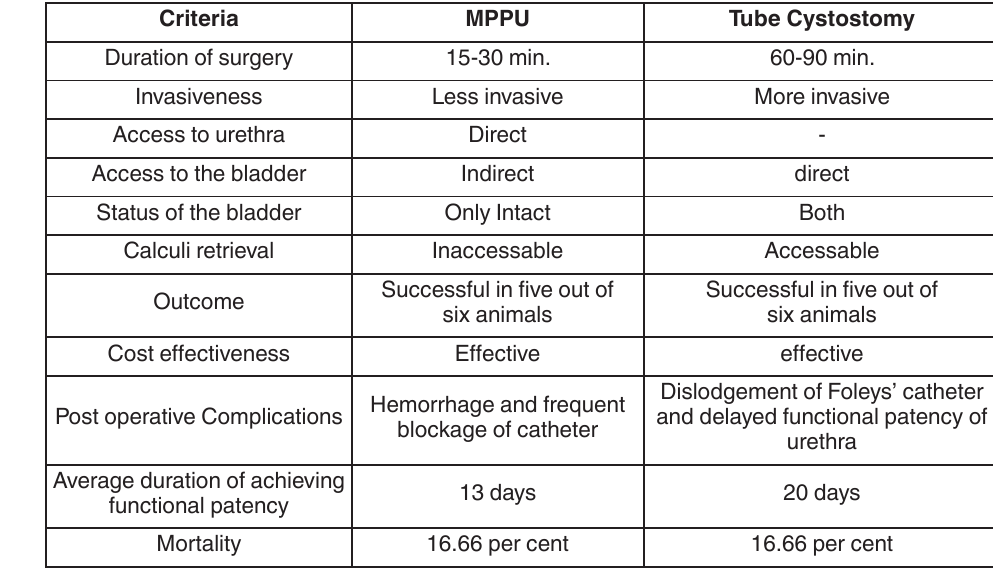
table 1: comparison of the surgical techniques of MPPU and tube cystostomy in chronic obstructive urolithiasis in goats